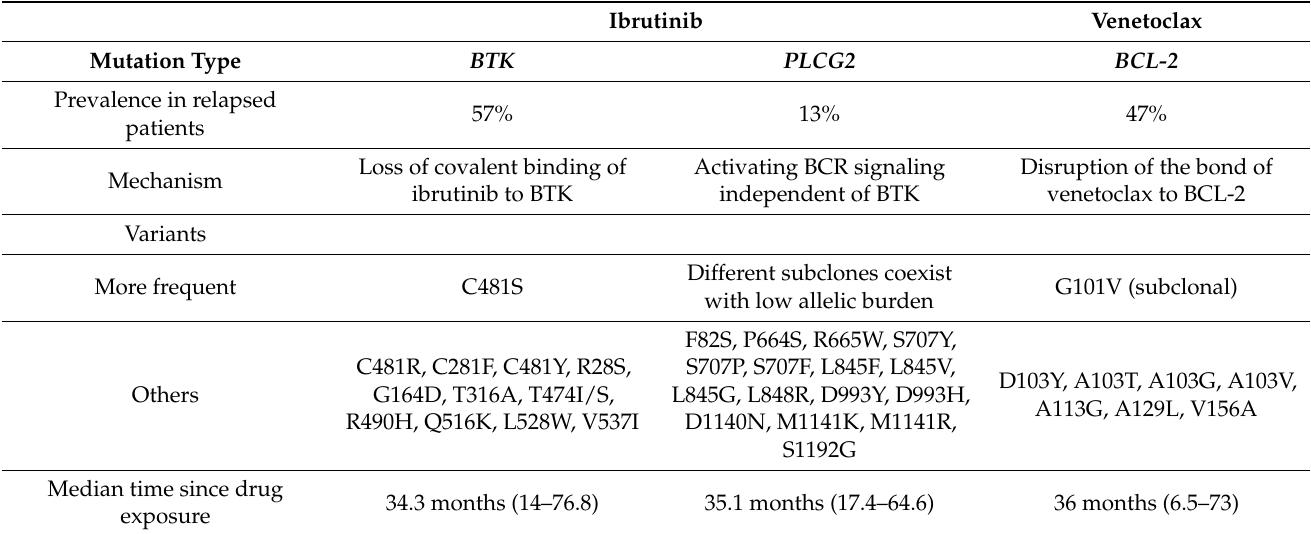
Table 4. Acquired mutations observed in patients that become resistant to ibrutinib and venetoclax. Ibrutinib Venetoclax Mutation